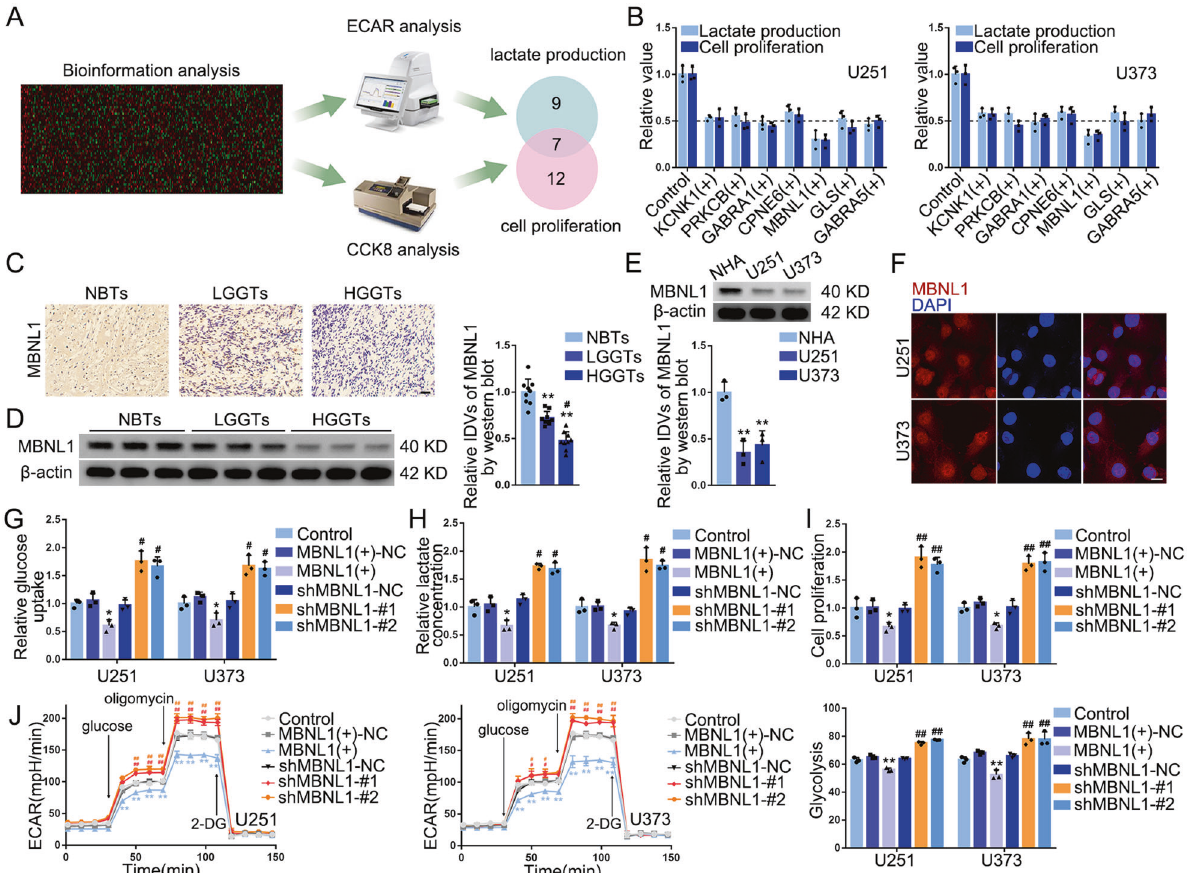
Fig. 1 Expression and Effect of MBNL1 in GBM Tissues and Cells after Identi fi cation of MBNL1 as a Glycolytic Suppressor. A Experimental scheme for identifying suppressors potentially related with both cell glycolysis and proliferation. B Lactate production and cell proliferation of U251 and U373 overexpressing 7 suppressors respectively. Data are presented as mean ± SD ( n = 3, each group). C IHC shows the expression and distribution of MBNL1 in NBTs (normal brain tissues), LGGTs, HGGTs (×200; scale bar represents 150 μ m). D NBTs deriving from regions adjacent to the GBM and GBM tissues of different grades (LGGTs, HGGTs) were analyzed for MBNL1 protein levels by western blotting. IDVs of the bands were statistically analyzed. Data are manifested as mean ± SD ( n = 9, each group). ** P < 0.01, compared with NBTs group; # P < 0.05 compared with LGGTs group. E Expression of MBNL1 in NHA, U251 and U373 cells. IDVs of the bands were statistically analyzed. Data are manifested as mean ± SD ( n = 3, each group). ** P < 0.01 compared to NHA group. F The distribution of MBNL1 in U251 and U373 cells was determined by IF assay (MBNL1 was labeled in red by secondary antibody against anti-MBNL1 antibody and nuclei were labeled in blue by DAPI. Scale bar represents 10 µm.). G – I Effects of overexpression or knockdown of MBNL1 on glucose uptake, lactate production, and proliferation of U251 and U373 cells were detected by glucose uptake, lactate, and cell proliferation assay respectively. Data are presented as mean ± SD ( n = 3, each group). * P < 0.05 compared with MBNL1( + )-NC group; # P < 0.05, ## P < 0.01 compared with shMBNL1-NC group. J Effects of MBNL1 overexpression or knockdown on ECAR in U251 and U373 cells were determined by XF24 Extracellular Flux Analyzer and glycolysis levels in each ECAR group were analyzed. Data are presented as mean ± SD ( n = 3, each group), ** P < 0.01 compared with MBNL1( + )-NC group; # P < 0.05, ## P < 0.01 compared with shMBNL1-NC group. Glycolytic capacity and glycolytic reserve in each ECAR group were analyzed (see Supplementary Fig. 1D,